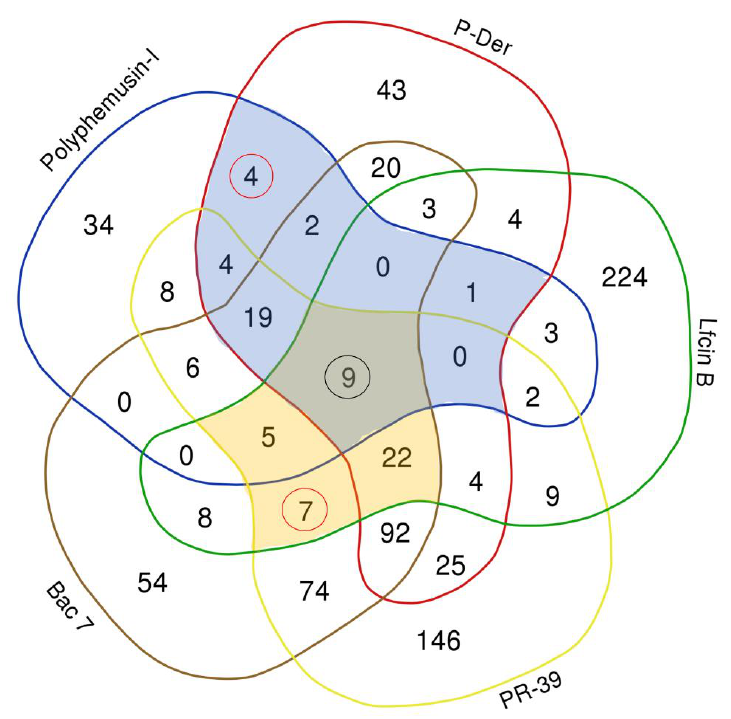
Figure 6. Venn diagram showing comparison of the protein targets of polyphemusin-I, P-Der, Lfcin B, PR-39 and Bac 7 identified using Escherichia coli proteome microarrays. The number of unique hits of polyphemusin-I, P-Der, LfcinB, PR-39 and Bac 7 were 34, 43, 224, 146, and 54, respectively. All the five AMPs (i.e., marine and terrestrial AMPs) shared nine protein targets (highlighted by black circle). The common protein targets between marine AMPs (polyphemusin-I, P-Der) were 39 proteins (shown under blue color region). Whereas 43 proteins (shown under yellow color region) were the common protein targets of terrestrial AMPs (Lfcin B, PR-39 and Bac7). The four and seven proteins (enclosed inside the circle) indicate the only common unique protein targets among marine AMPs and terrestrial AMPs, respectively. Table 6. Enrichment results for the 39 common protein targets of polyphemusin-I and